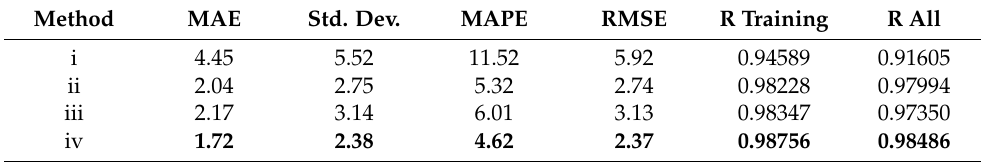
Table 5. Results of the simplified